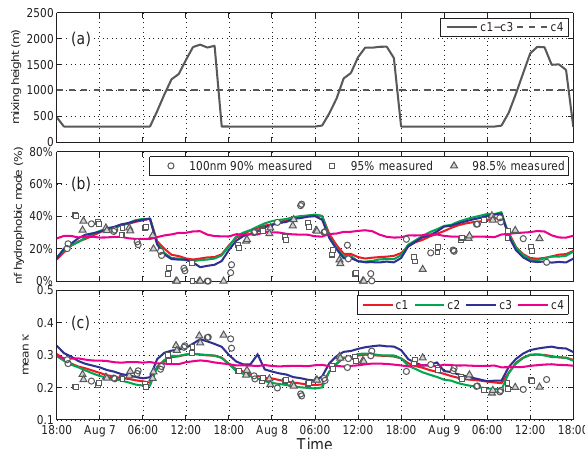
Fig. 9. Comparisons between the PartMC-MOSAIC simulations and the HH-TDMA measurements. (a) Mixing layer height set for different cases; (b) number fraction of nearly-hydrophobic parti- cles; (c) mean hygroscopicity parameter κ of all groups. See Table 3 for the settings in the model for the four cases (c1-c4)